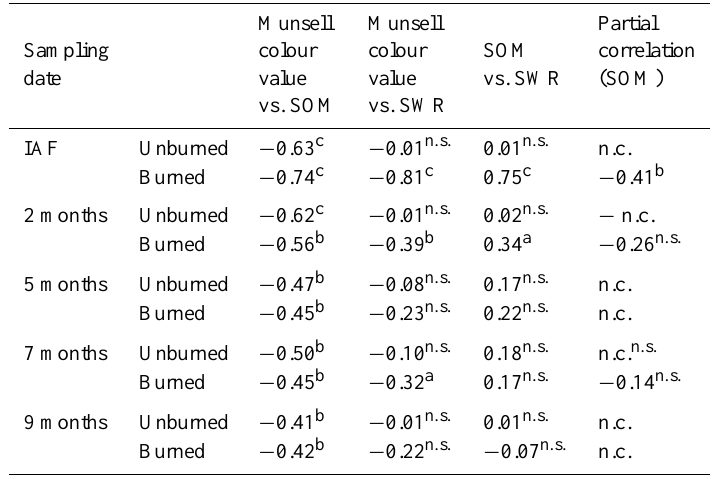
Table 5. Coefficients of correlation between the studied variables in the burned